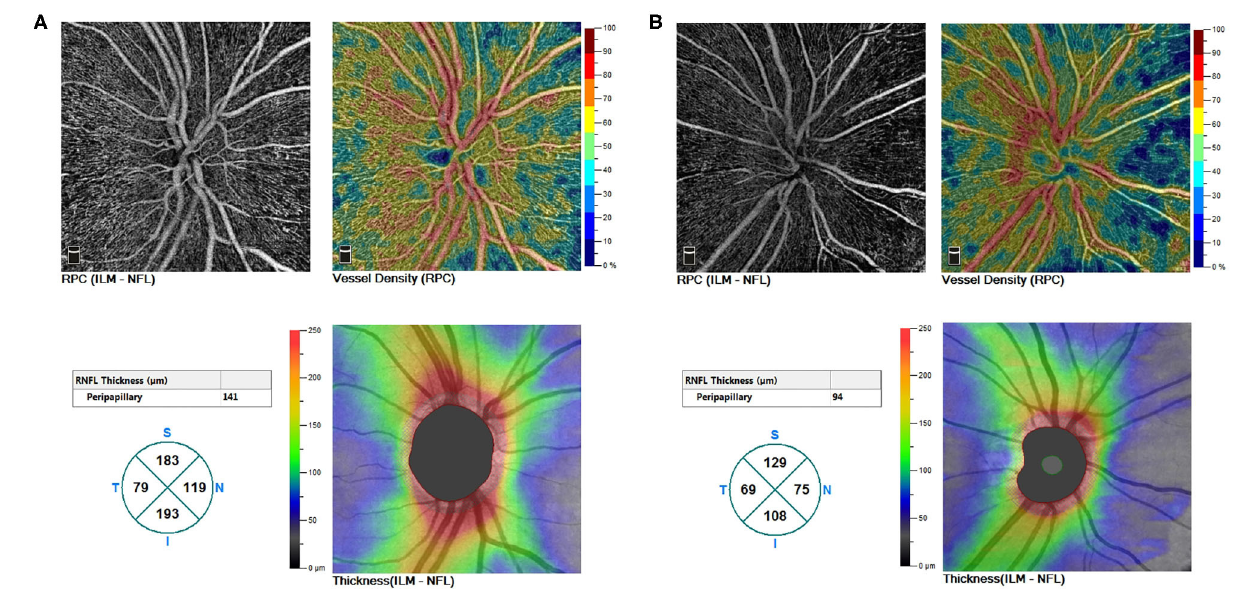
Non-myopic eyes ( n = 195)